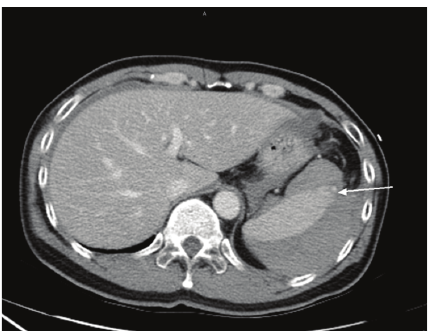
Figure 1: Massive hyperdense ascites surrounded around the spleen without free air.